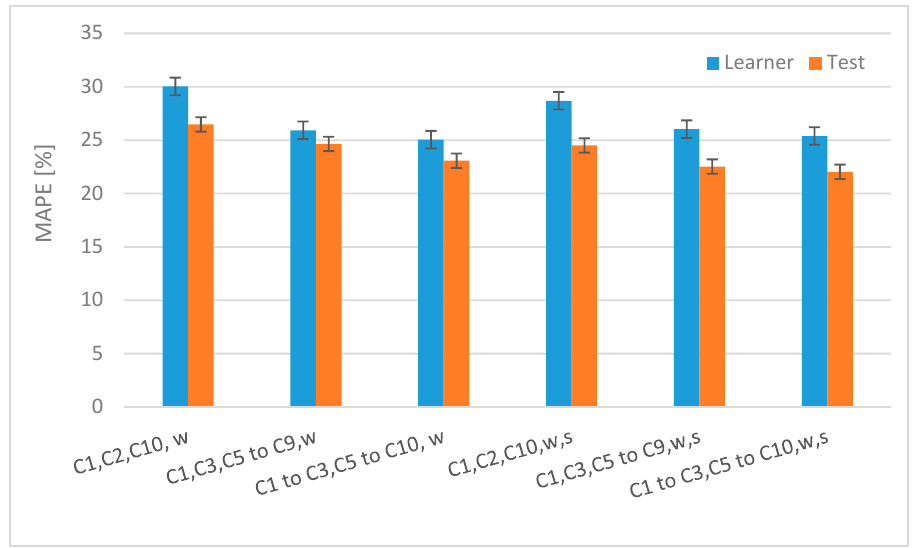
Figure 8. Assessment of the quality of the developed models of the total waste accumulation indicator for determined clusters in a varied system of input variables.